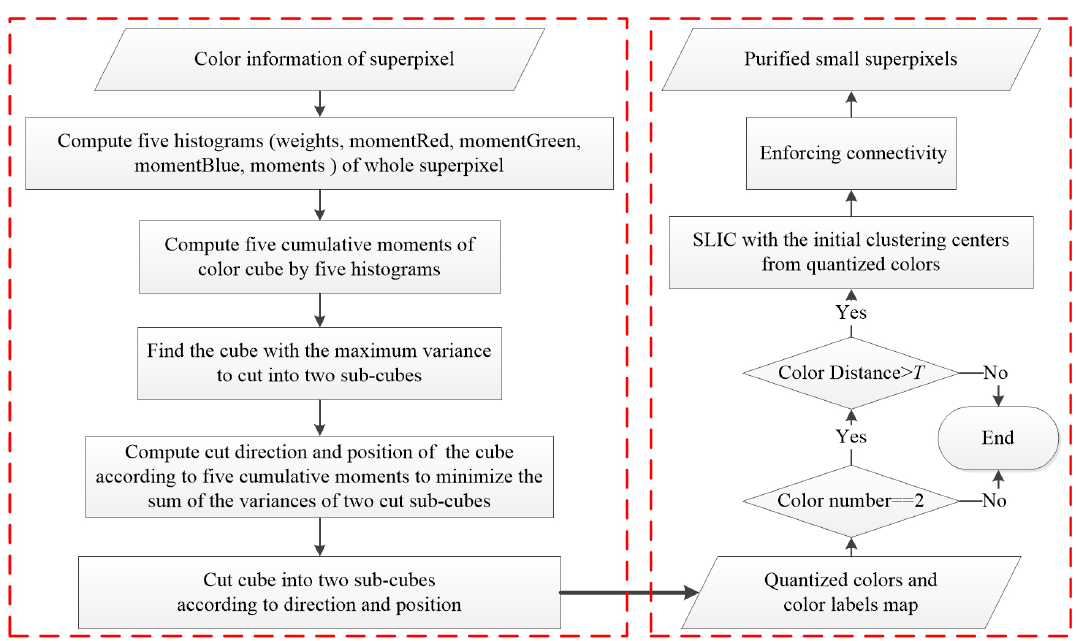
Figure 2. Procedure of the superpixels purification algorithm based on color